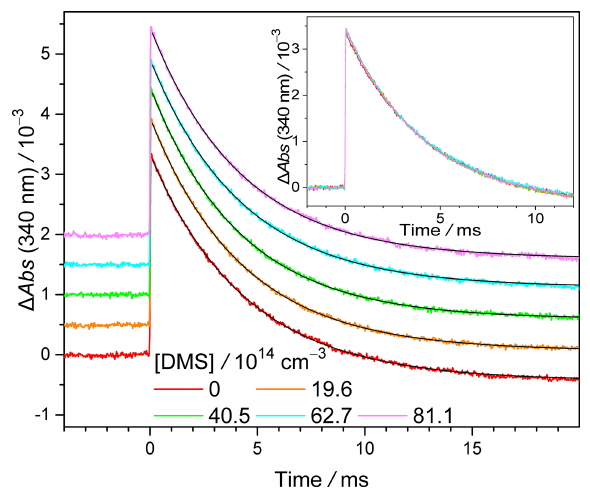
Figure 1. Representative time traces of CH 2 OO absorption recorded at 340 ± 5nm under various [DMS] values. The traces are shifted upward by various amounts for clearer visualization. Smooth black lines are the exponential fit. The photolysis laser (308nm) pulse defines t = 0. The negative baseline (more obvious at long reaction time) is due to depletion of the precursor, CH 2 I 2 , which absorbs weakly at 340nm ( σ = 8.33 × 10 − 19 cm 2 ) (Atkin- son et al., 2008). This depletion is constant in the probed time win- dow and would not affect the kinetics of CH 2 OO. The inset shows the profiles without upshifting to show the overlapping. See Exp#1 of Table S1 for detailed experimental conditions.